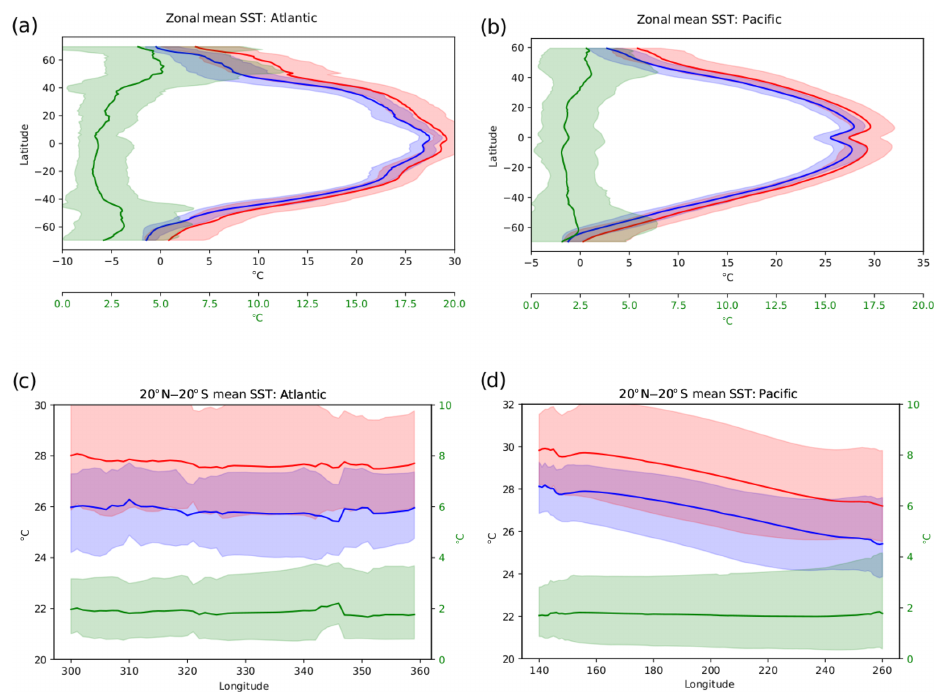
Figure 4. Panels (a, b) show the zonally averaged SST over the Atlantic region (70 ◦ W–0 ◦ E) and the Pacific region (150 ◦ E–100 ◦ W) respectively. Panels (c, d) show the SST averaged between 20 ◦ N and 20 ◦ S for the Atlantic and Pacific respectively. In all figures, blue shows PI Ctrl , red shows Plio Core and green shows the anomaly between them. The solid line shows the multi-model mean, while the shaded area shows the range of modelled